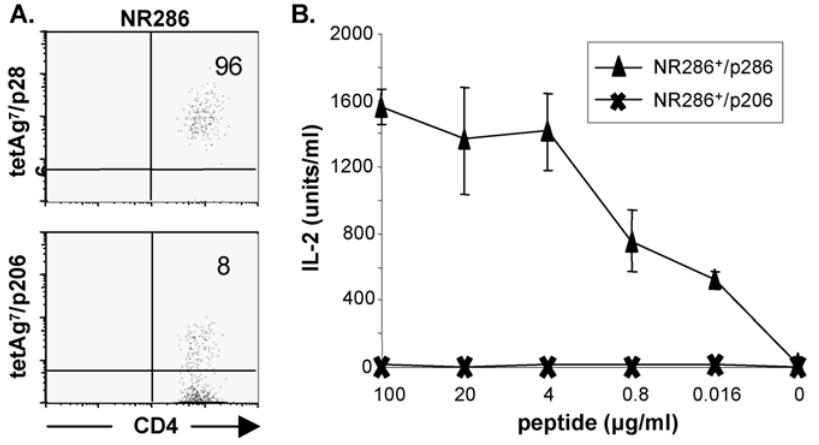
Figure 1. Isolation and characterization of CD4 + NR286 T cells. ( A ) FACS analyses of purified NR286 T cells stained with tetAg7/p286 tetramer and an anti-CD4 antibody or tetAg7/p206 (as a negative control). The numbers shown in each quadrant represent the percentage of cells stained by the tetramer. ( B ) IL-2 production by NR286 T cells (2 6 10 5 /well) in response to various concentrations of p286 or control p206 peptides plus NOR mouse APCs (4 6 10 5 /well). Peptides were 5-fold serially diluted from 100 m g/ml. HT-2 cells were used as the indicator in a MTT assay. Data represent average 6 SEM, n=3.